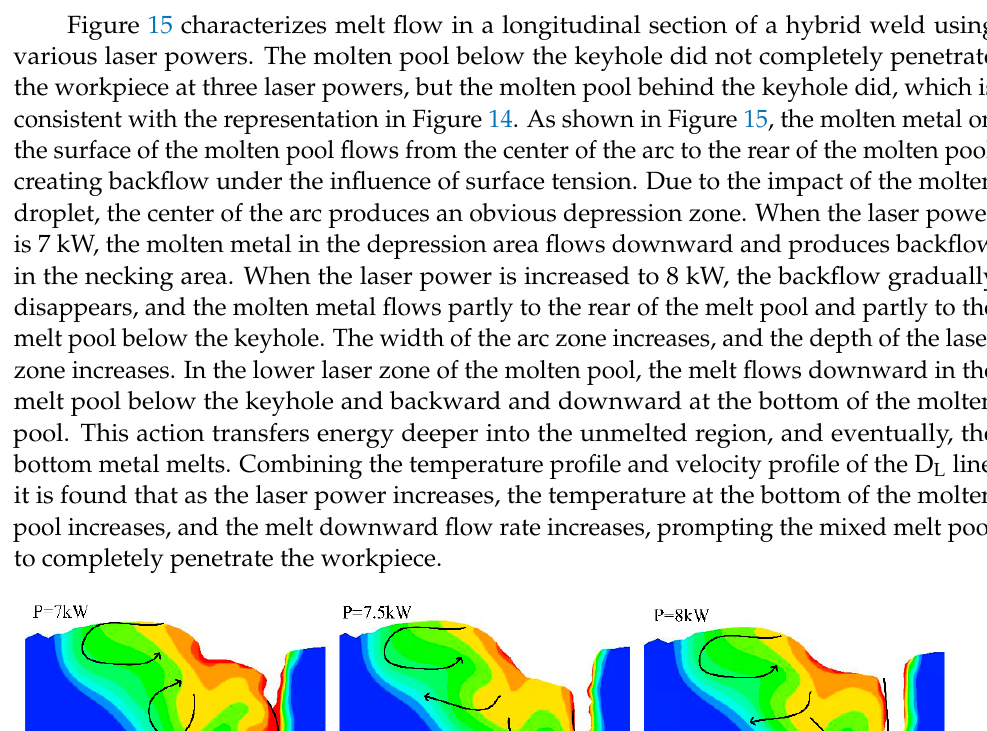
Figure 16. Location of microstructure selection.